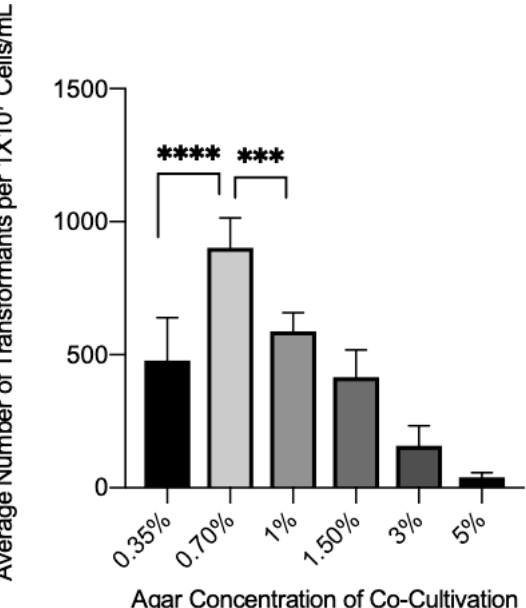
transformation efficiency was seen at the 50:1 ratio, which increased transformation 3-fold compared to the baseline ratio.